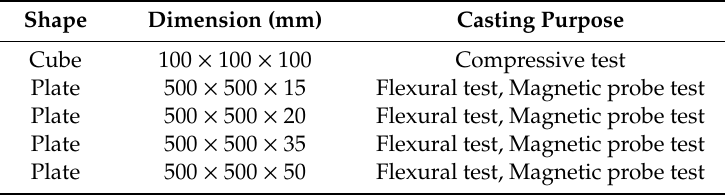
Table 2. Specimen list and casting purpose for different types of specimens.